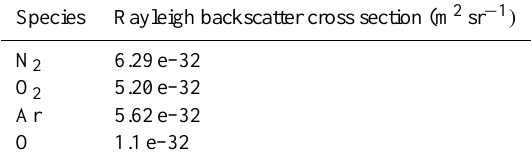
Table 1. Rayleigh backscatter cross-sections at 532nm.